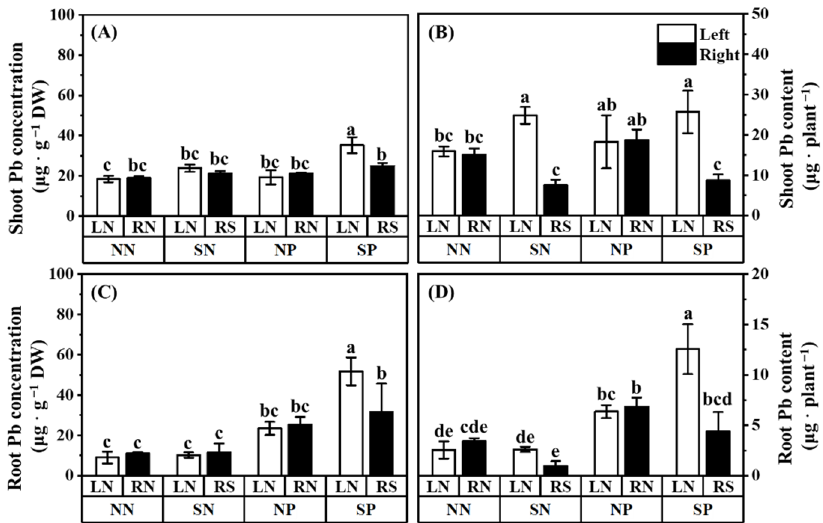
Figure 5. Effects of Pb and shading on the shoot Pb concentration ( A ), shoot Pb content ( B ), root Pb concentration ( C ), and root Pb content ( D ) in the leaves of M. alba . F and p -value of ANOVA are listed in Supplementary Table S3. Different letters above the columns in each graph indicate a sig- nificant difference among the means by Tukey’s test ( p < 0.05 ). The abbreviation is consistent with Figure 1.